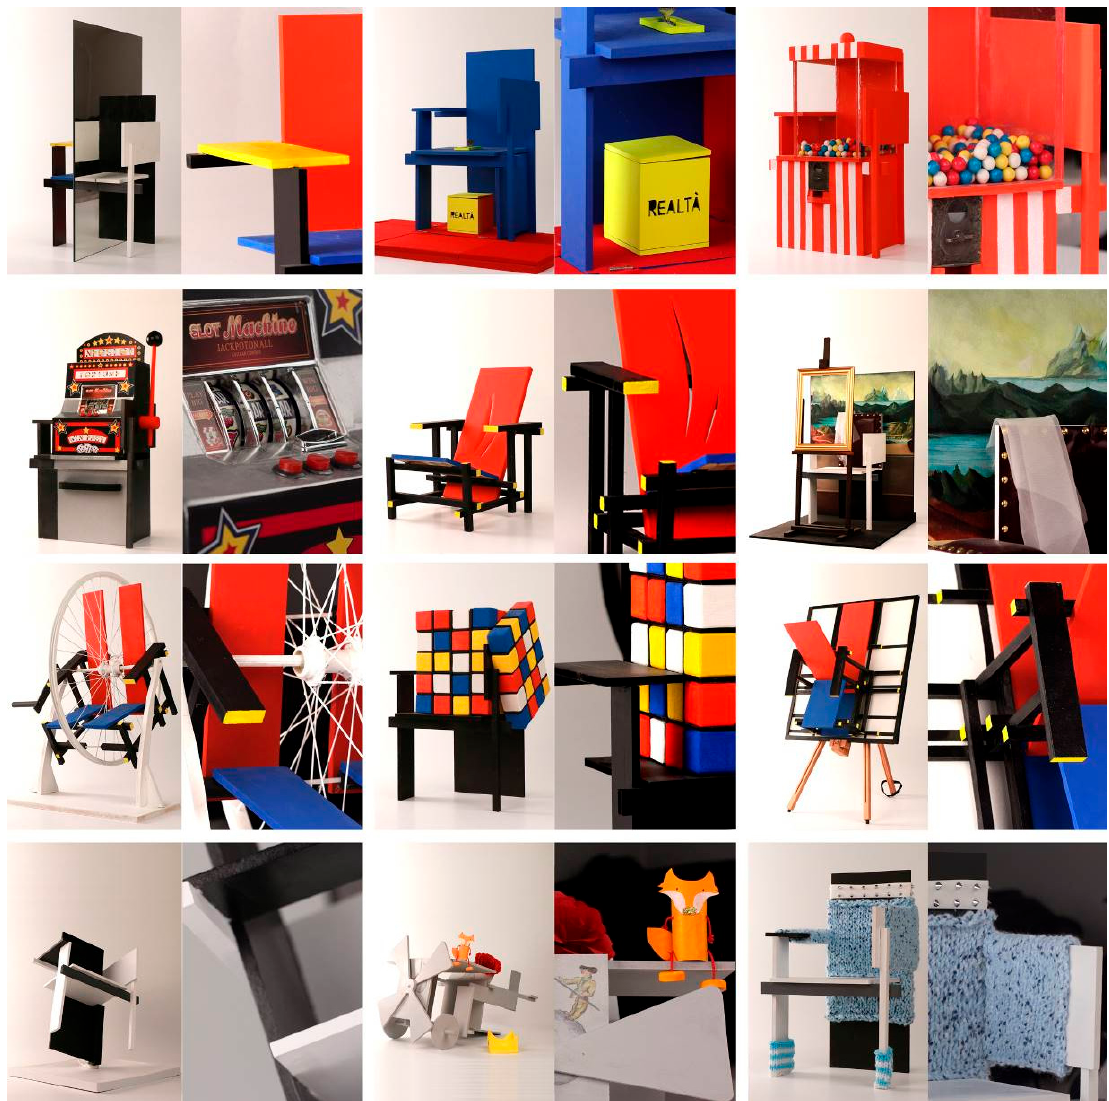
Figure 2. Some of Rietveld’s chairs, conceived and built by the